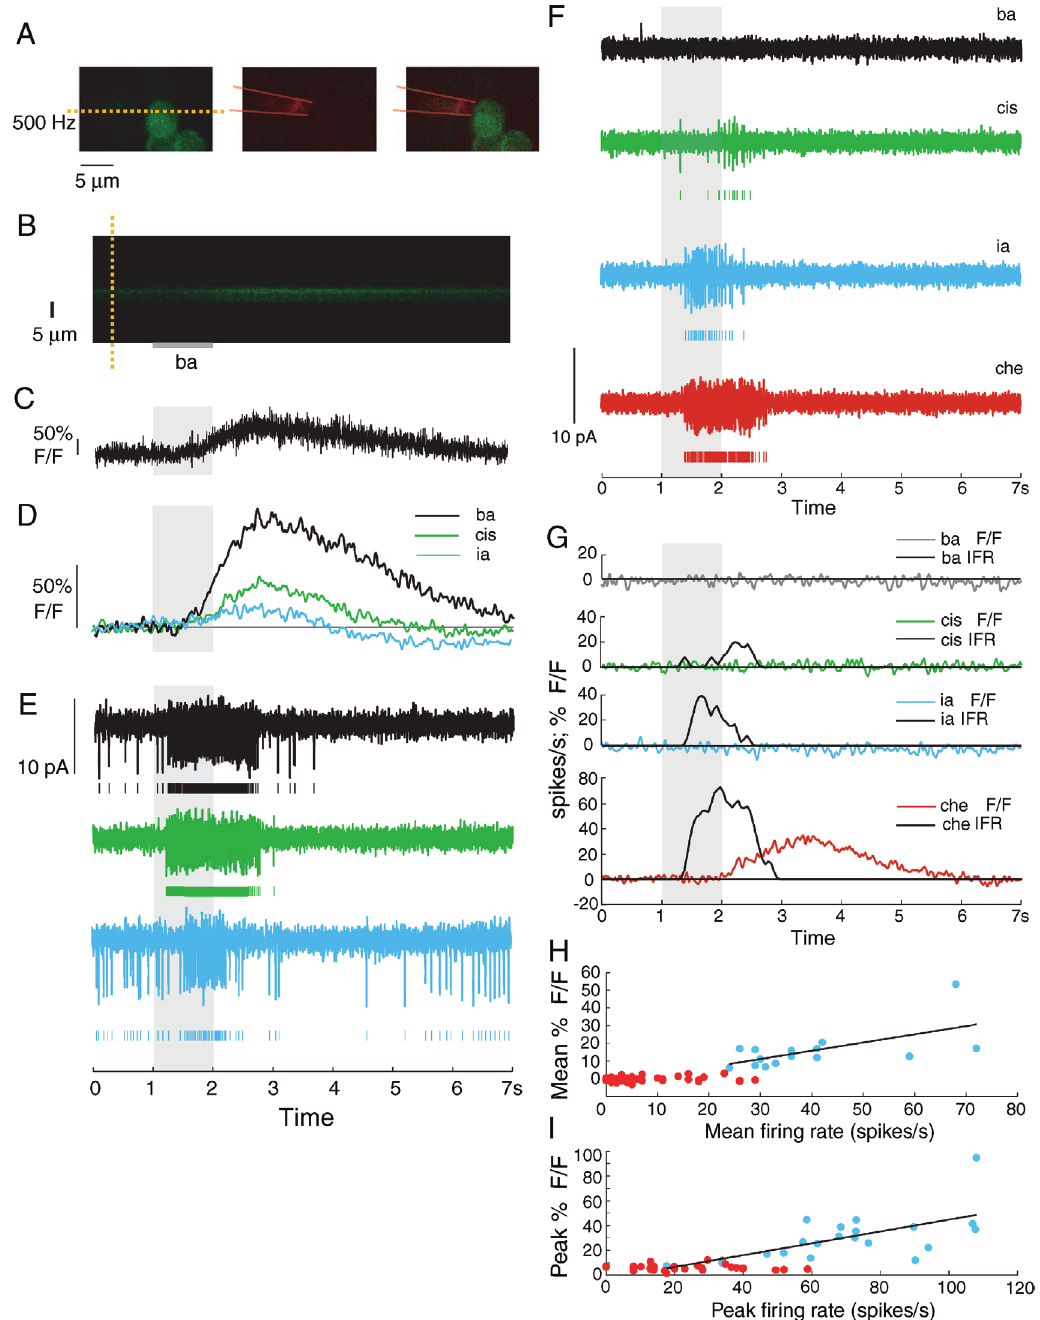
Figure 3. Simultaneous electrophysiology and 2-photon G-CaMP imaging of GH146-Gal4, UAS-GCaMP PNs . ( A ) Shows (from left) G-CaMP-positive PN in green channel, patch electrode in red (outline of approximate electrode position drawn by hand), merge. Yellow dashed line shows line chosen for line scanning in this experiment. ( B ) Results of line scan. Shown is the change in intensity levels as the odor is presented. ( C ) Raw and unfiltered single trial imaging signal ( ∆ F/F) –based on integrating over the appropriate window in B– shows clear response to odor pulse, but with slow rise time. ( D ) Filtered G-CaMP signal shows responses to three odors (ba, cis, and ia). Imaging signal in response to ia is just barely detectable. ( E ) Simultaneously recorded electrophysiological signal showing PN responses to ba, cis, and ia. For each odor response, the first row shows raw signal, second row shows spikes detected. ( F ) Electrical recordings of odor responses of a PN from a different fly (also GH146-Gal4, UAS-GCaMP). ( G ) Results of simultaneous line scanning of the same PN’s soma for the same odors. Shown is the change in fluorescence levels as the odor is presented. Also shown for comparison is the instantaneous firing rate based on simultaneous electrical recordings. G-CaMP signal shows high threshold of activation. Response to ia evoked greater than 40Hz of activity, but did not evoke any G-CaMP signal. ( H ) Mean ∆ F/F following odor presentation is partially correlated with the mean firing rate (during 1second odor period) of various PNs in response to odor presentations. Red dots represent points that fall within 2.5SDs of baseline variation). Best-fit linear regression lines for significant points shown in black. Correlation value for trials with significant ∆ F/F values: 0.61. Pearson’s r 2 is thus0 .38. ( I ) Peak ∆ F/F following odor presentation is partially correlated with the peak firing rate (during 1second odor period) of various PNs in response to odor presentations. Red dots represent points that fall within range of peak baseline variation). Best-fit linear regression lines for significant points shown in black. Correlation value for trials with significant ∆ F/F values: 0.51. Pearson’s r 2 is thus